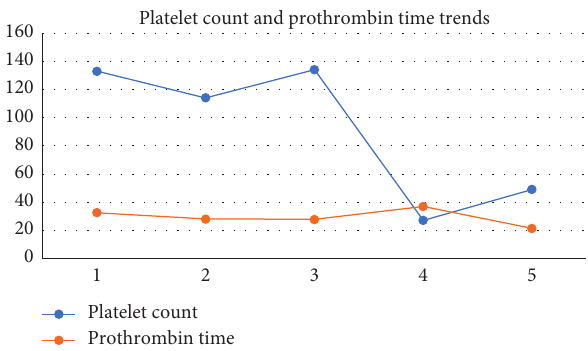
Figure 3: Trends of platelet count and prothrombin time in the first 6 days of